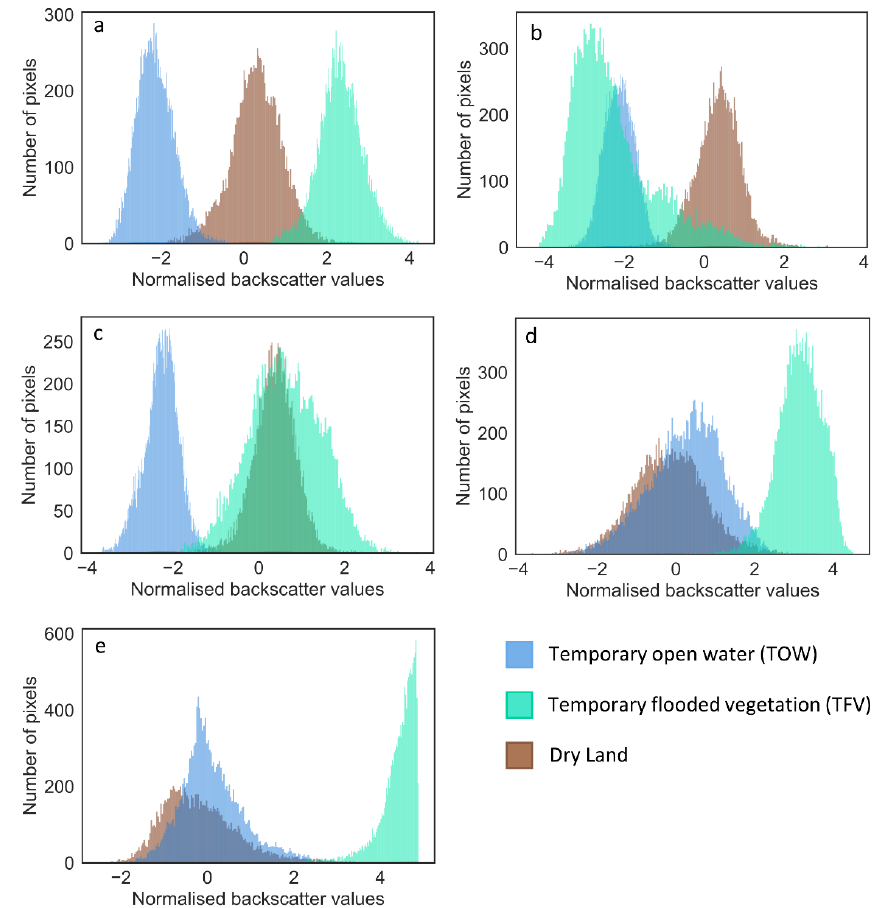
Figure 7. Histogram distributions of training data for the classes TOW, TFV, and Dry Land for individual time series features. Z-score VV ( a ), Z-score VH ( b ), Z-Score VV + VH ( c ), Z-Score VV-VH ( d ), and Z-Score VV/VH ( e ).